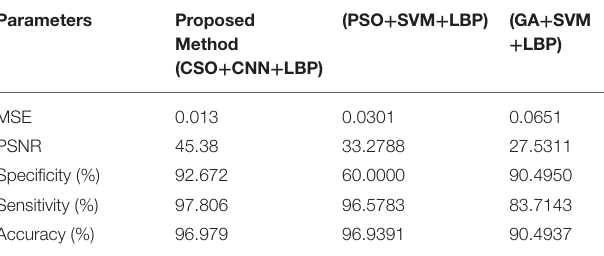
TABLE 2 | Comparative Results with proposed